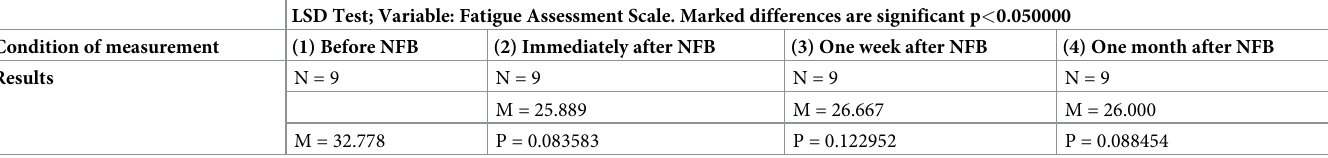
Table 1. Score for fatigue before and after NFB measured by Fatigue Assessment Scale.